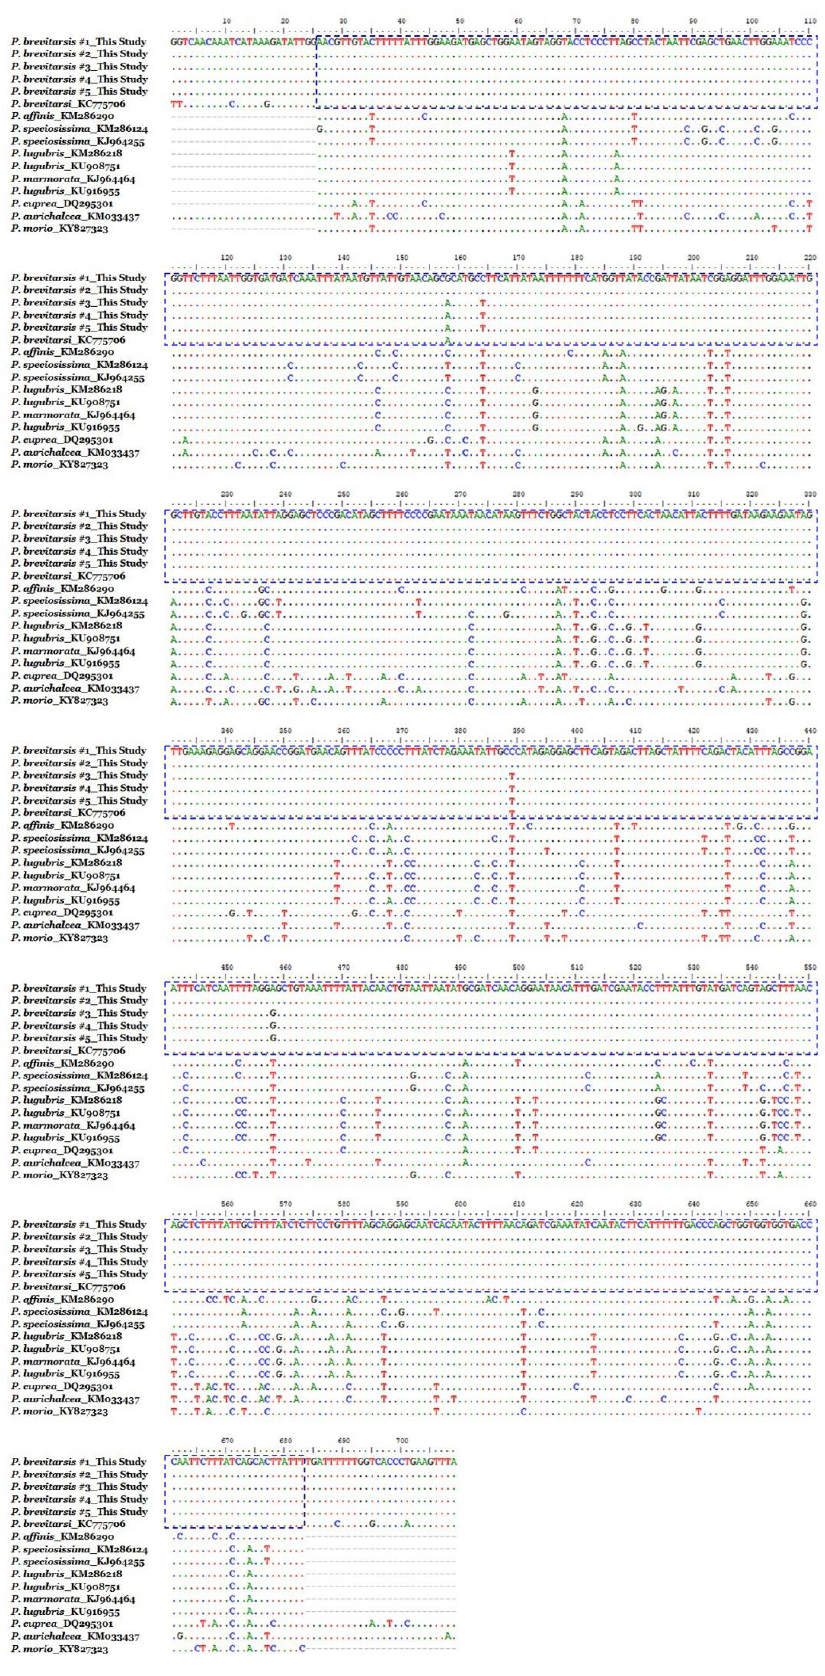
Figure 1. Comparative analysis of the cytochrome oxidase subunit 1 DNA barcode sequences between Protaetia brevitarsis